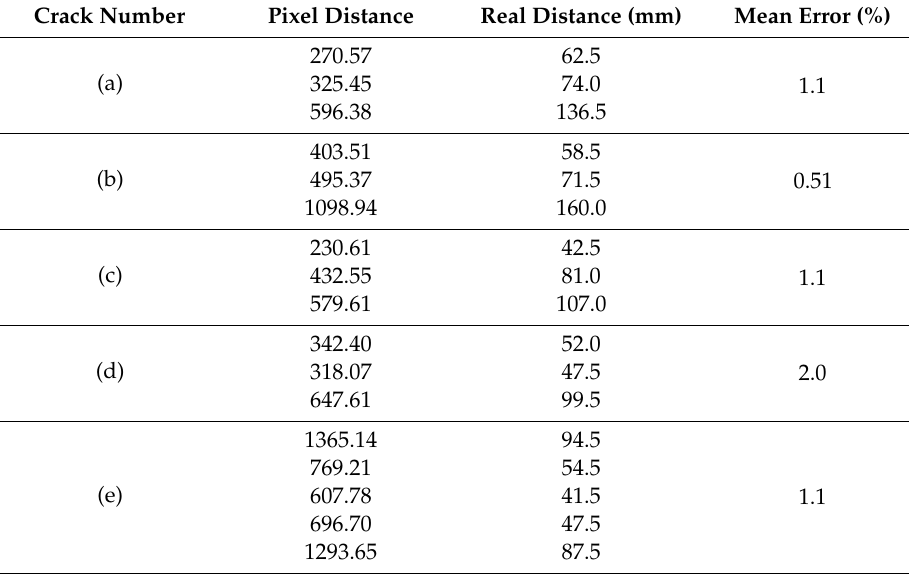
Table 4. Accuracy validation of image